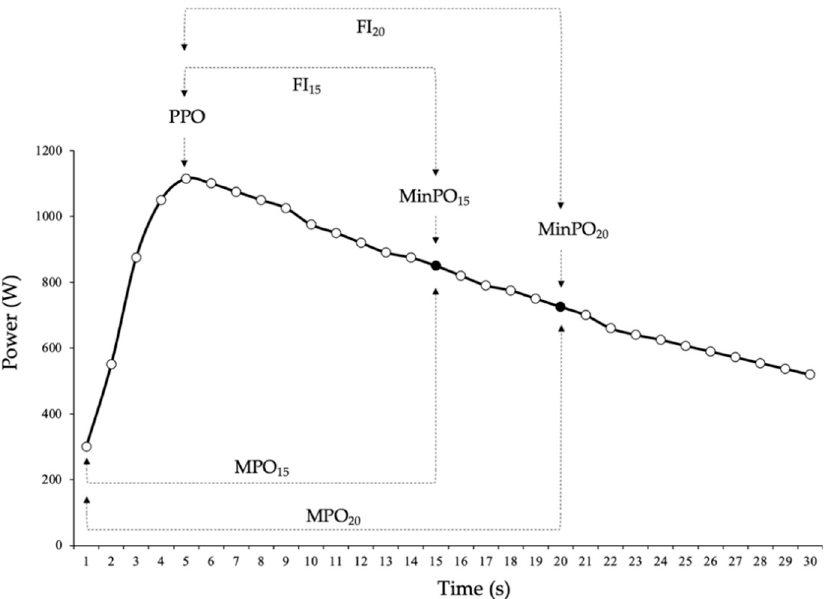
Figure 2. A representative example of the instantaneous power output during the traditional 30 s Wingate Anaerobic Test (WAnT) and specific values used to calculate the predictor variables included in the regression models. PPO: Peak power output, MinPO: Minimal power output, MPO: Mean power output, FI: Fatigue index.